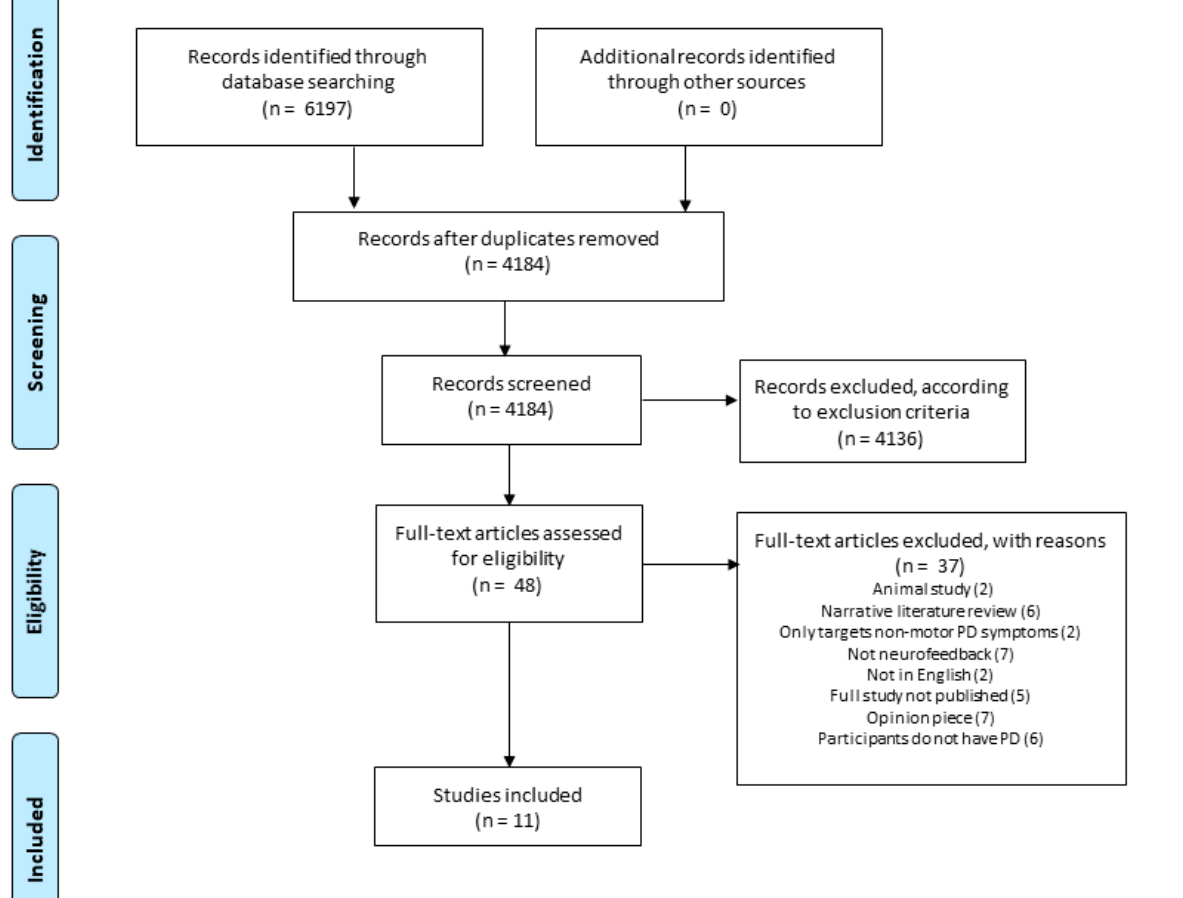
Figure 1. PRISMA flowchart for the literature search